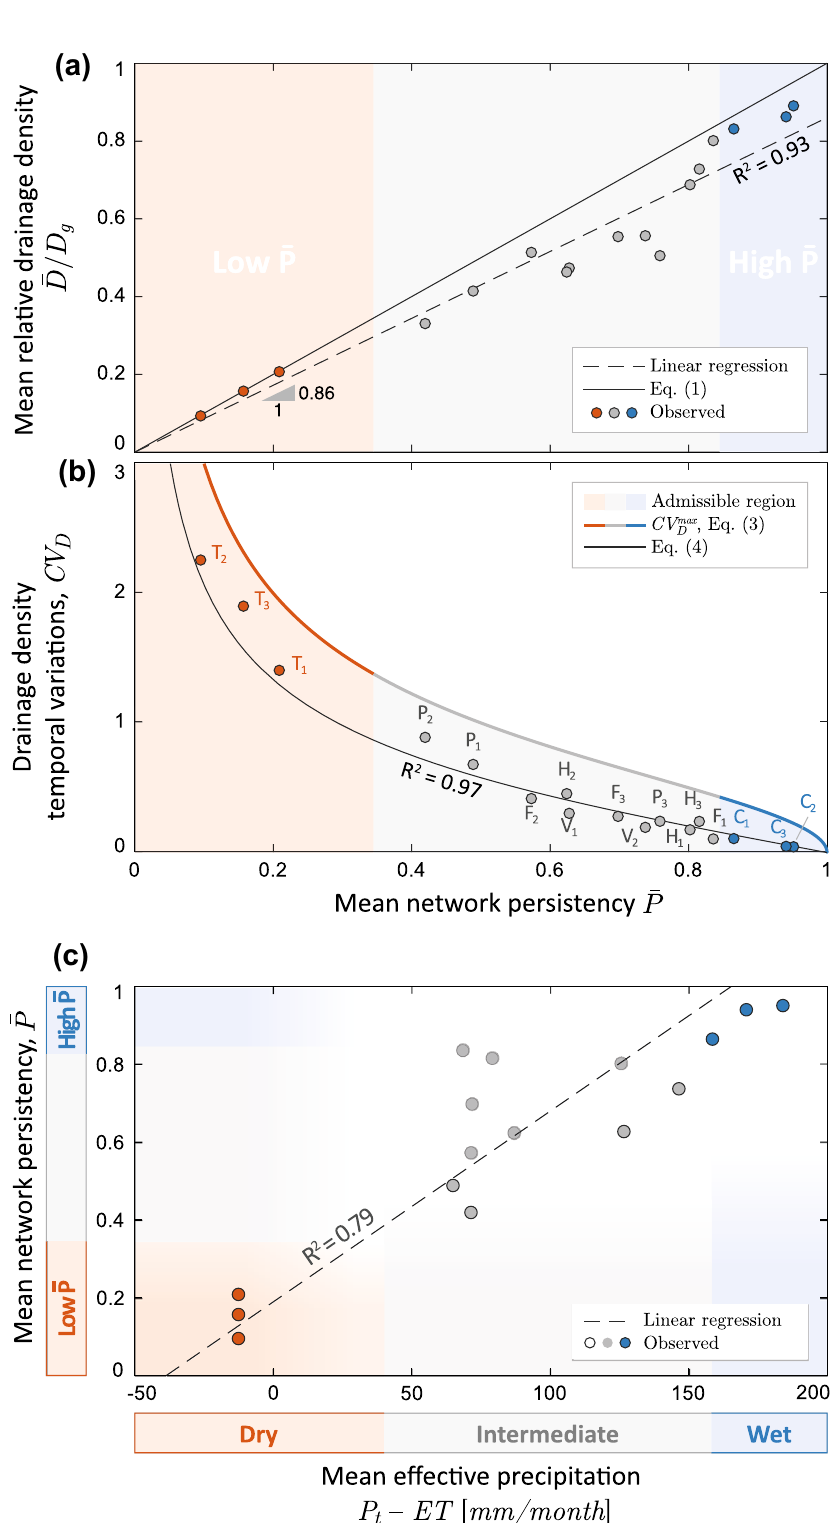
Figure 2. Climatic controls on the active drainage density. ( a ) mean drainage density scaled to the geomorphic drainage ¯ P ; ( b ) coefficient of variation of the drainage density as a function density as a function of the mean network persistency, ¯ P . Also shown here are the maximum theoretical limit for CV D (Eq. (3)) and the value of of the mean network persistency CV D predicted by the hierarchical beta-model (Eq. (4)); ( c ) the correlation between mean network persistency and effective precipitation (total precipitation minus potential evapotranspiration ET) during the period when the active network was surveyed (average monthly value among all the months during which at least one field survey was performed). Points with a lighter gray border represent cases in which the surveys are not evenly distributed within the study period (Hubbard Brook and Fernow) as the median time between all the possible pairs of survey dates, τ m , was smaller than 15 days. P 3 was not included in this plot because of the lack of reliable precipitation